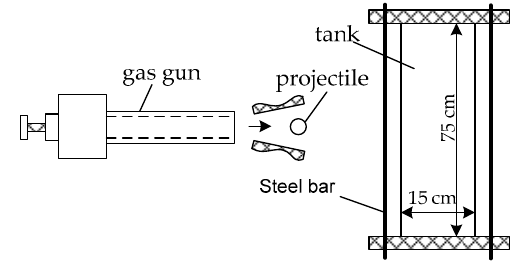
Figure 1. Schematic diagram of the Varas test device.